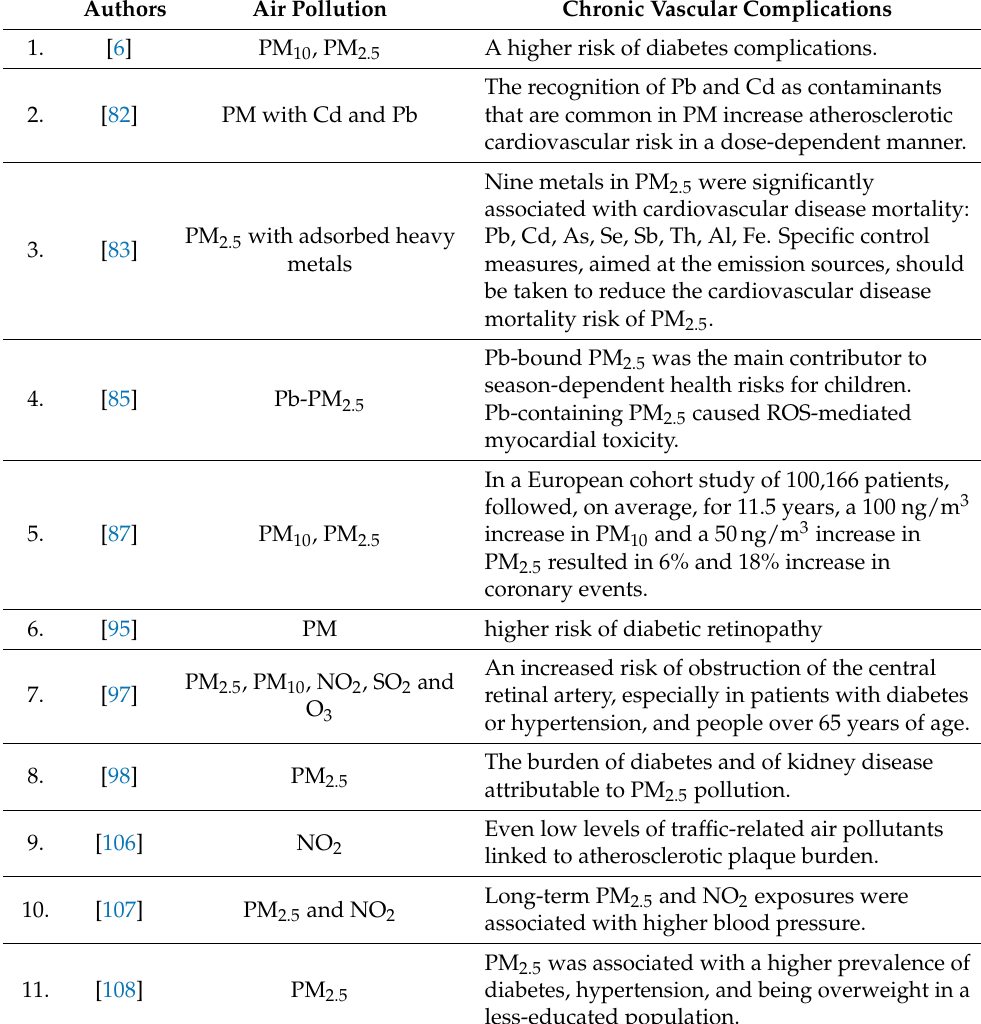
Table 3. Air pollution and chronic vascular